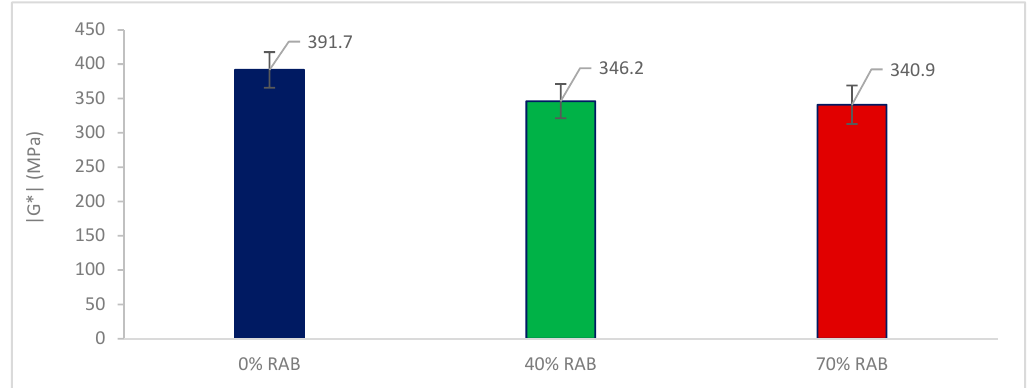
Figure 8. | G* | at 15 ◦ C and 10 Hz for the three mortar mixes. Figure 8. |G*| at 15 °C and 10 Hz for the three mortar mixes. Figure 8. |G*| at 15 °C and 10 Hz for the three mortar mixes.